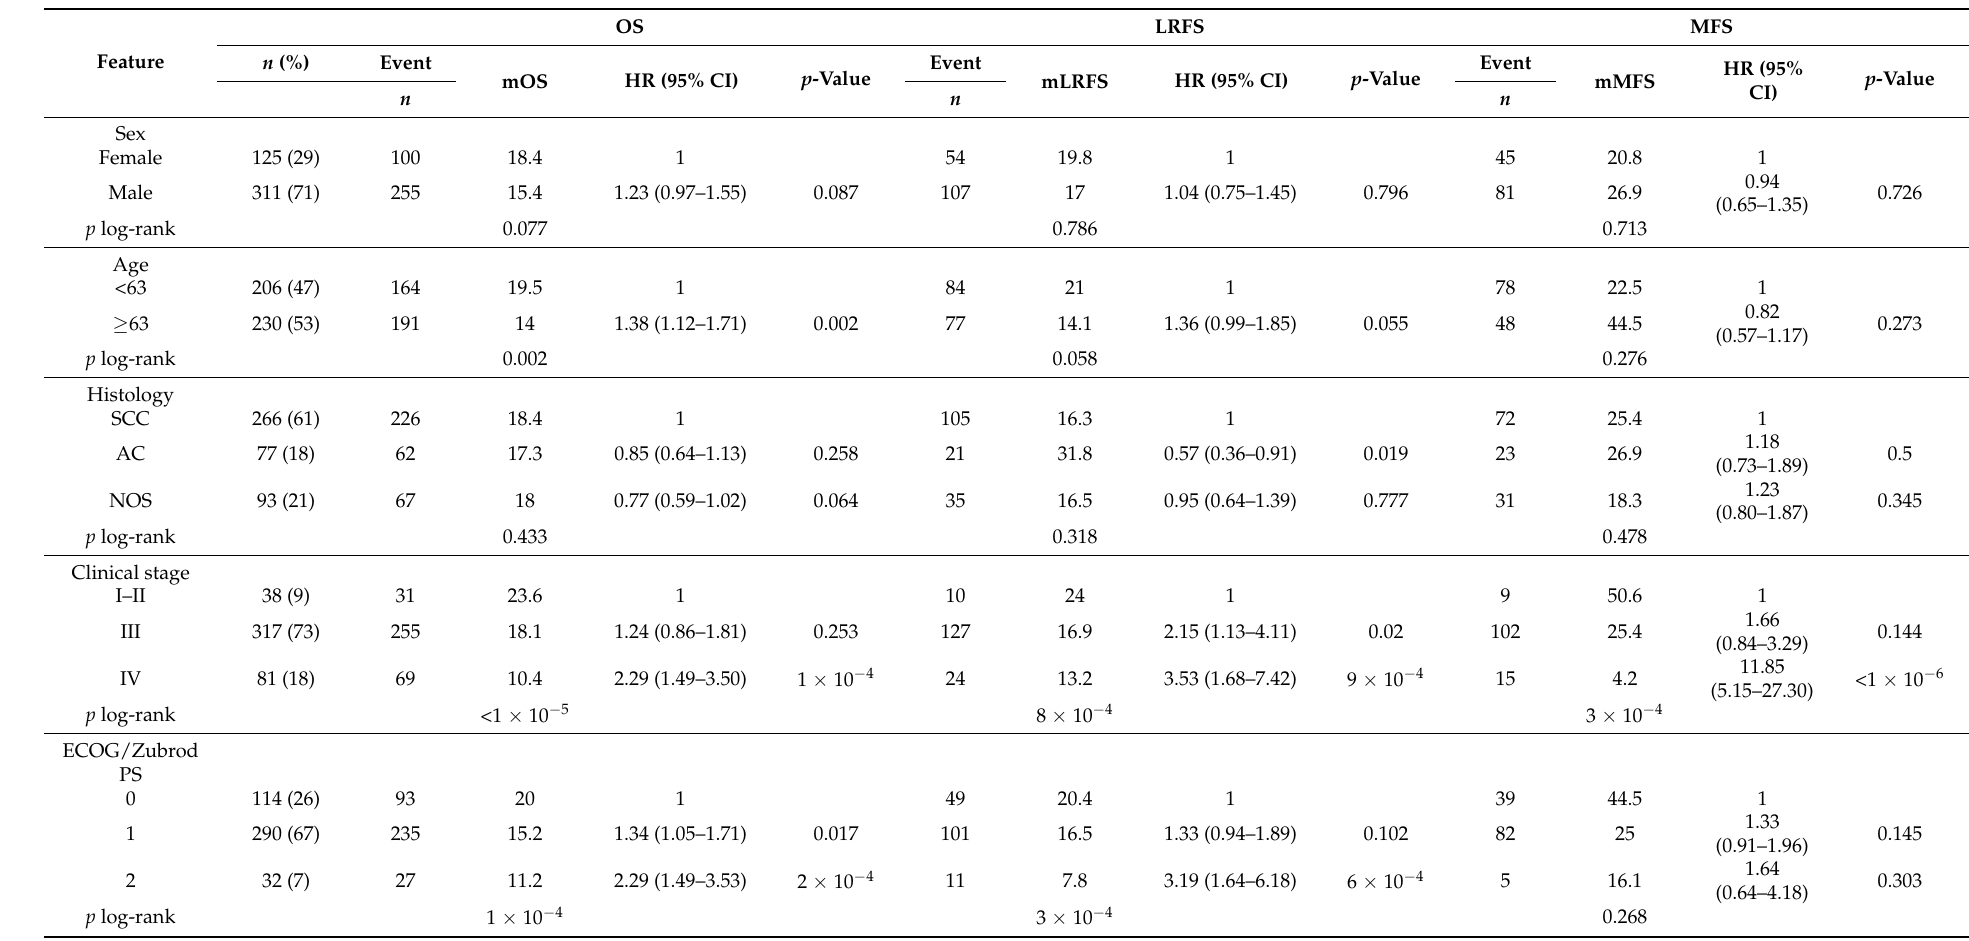
Table 1. Patient characteristics and